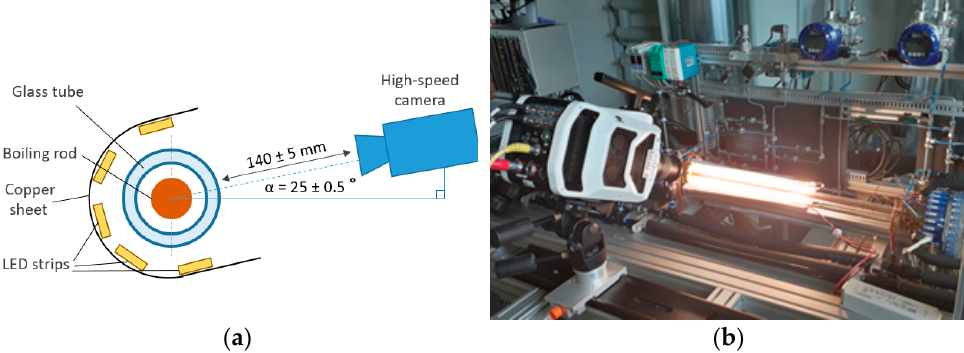
Figure 4. Image acquisition setup. ( a ) Camera and lighting configuration schematic (not to scale). ( b ) Image acquisition with Phantom v1212 camera in action.